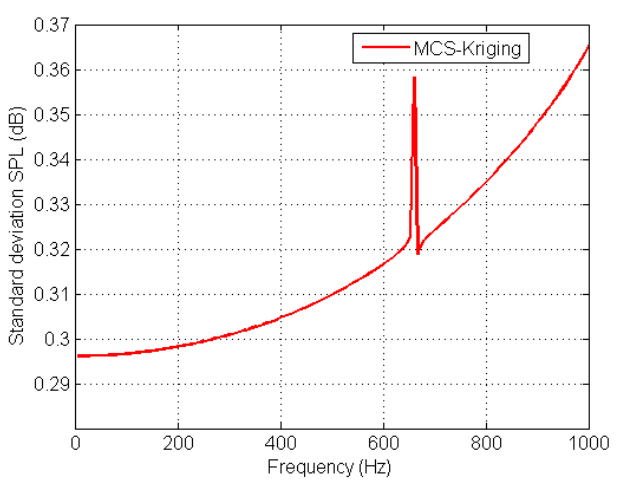
Figure 9. Mean value of the SPL.